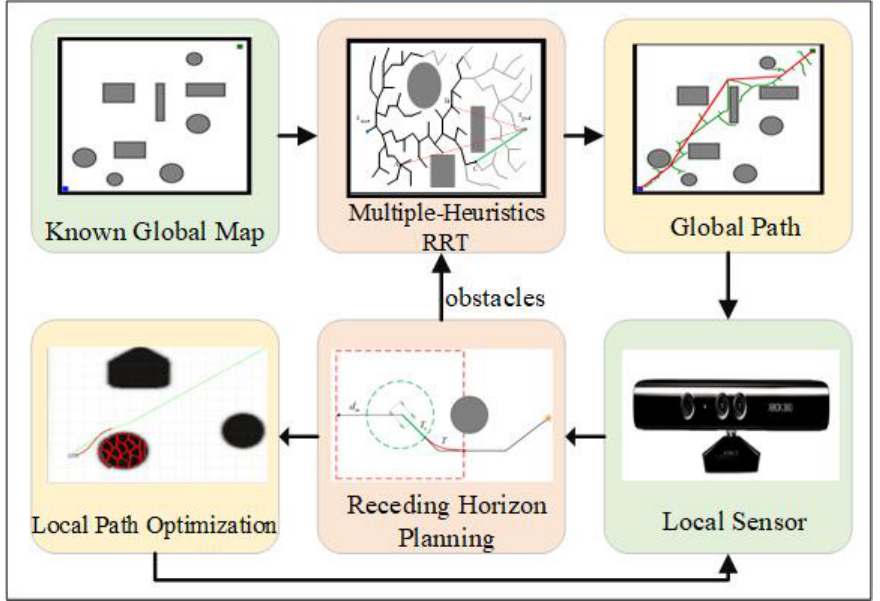
Figure 3. Illustration of the system overview. The path planning system is composed of two main parts: The global path planning and the local path